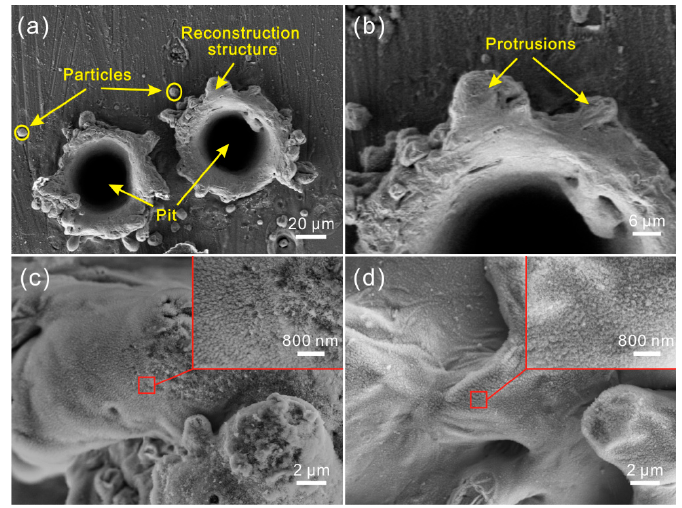
Figure 2. ( a ) SEM image of the microstructure on Al alloy surface treated by laser micro-engraving (laser beam pulse frequency of 10,000 Hz, laser beam scanning speed of 0 m/s); ( b ) high-magnification SEM image of the microstructure; ( c ) high-magnification SEM images of convex structure of the microstructure; ( d ) high-magnification SEM images of the pit.